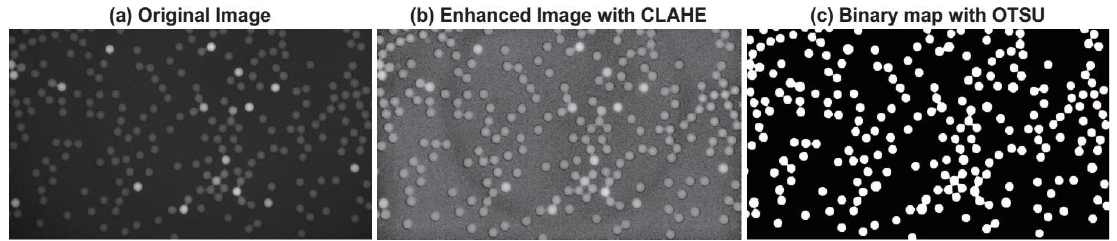
Figure 3. Intermediate results of contrast-limited adaptive histogram equalization (CLAHE) and OTSU on the overall micro-droplet detection: ( a ) Original image. ( b ) Enhanced image with CLAHE ( J ). ( c ) Binary map with OTSU ( K